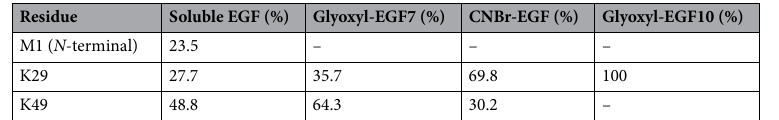
Table 2. Relative abundance (%) of EGF peptides containing putative binding sites to the agarose carrier, obtained by LC–ESI–MS/MS analysis.